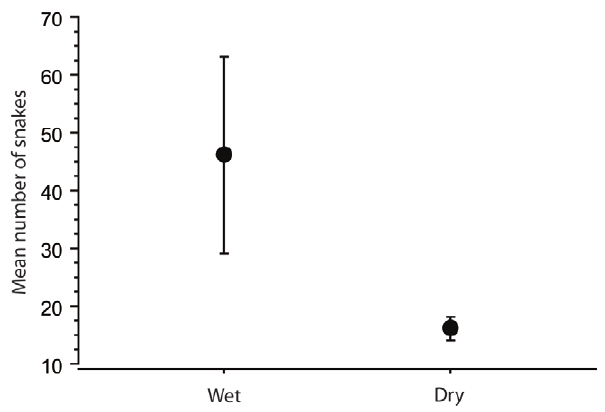
Figure 3. Mean number of snakes counted during wet ( . 1000 mm, 6 mo precipitation, N=3) and dry ( , 1000 mm, 6 mo precipitation, N = 3) years. Vertical bars denote 95% confidence intervals for the mean of